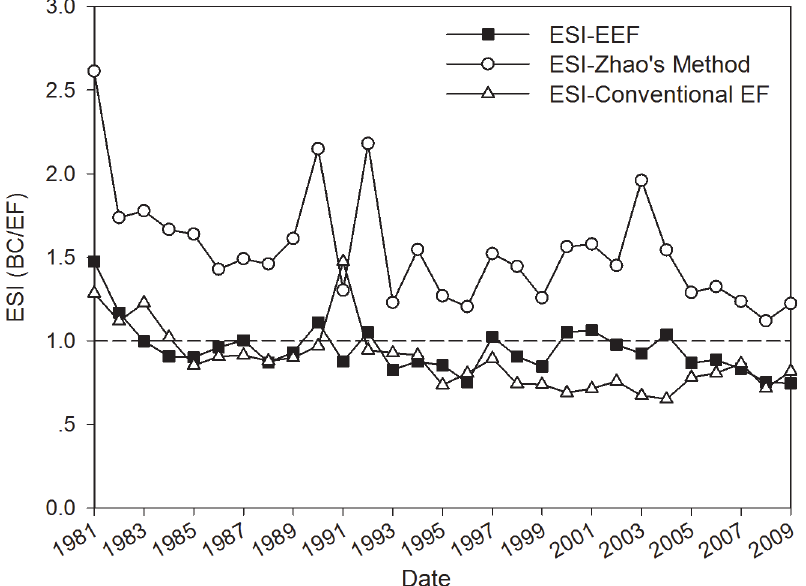
Fig 5. The three data series of the ecological sustainability index (ESI) during the period 1981 – 2009 based on three ecological footprint approaches for Yuanzhou County, Ningxia Hui Autonomous Region,